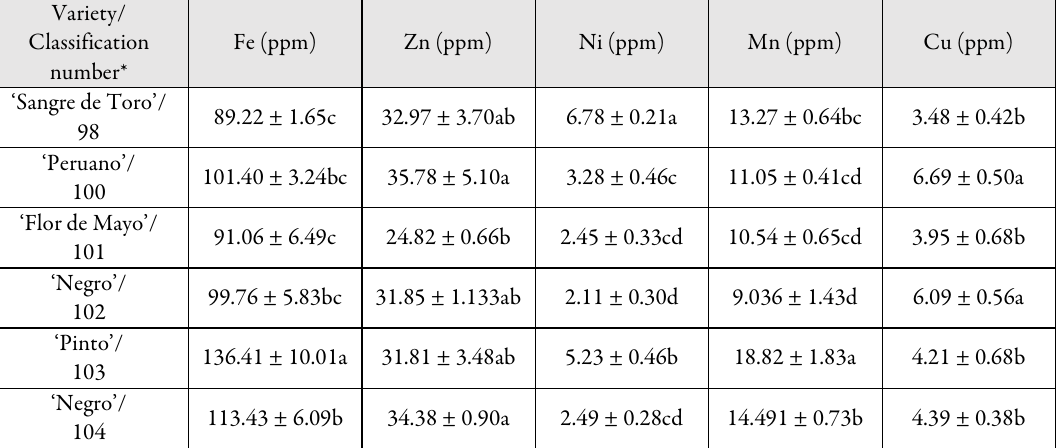
Table 5. Micronutrient concentration in common bean varieties produced in Morelos State,